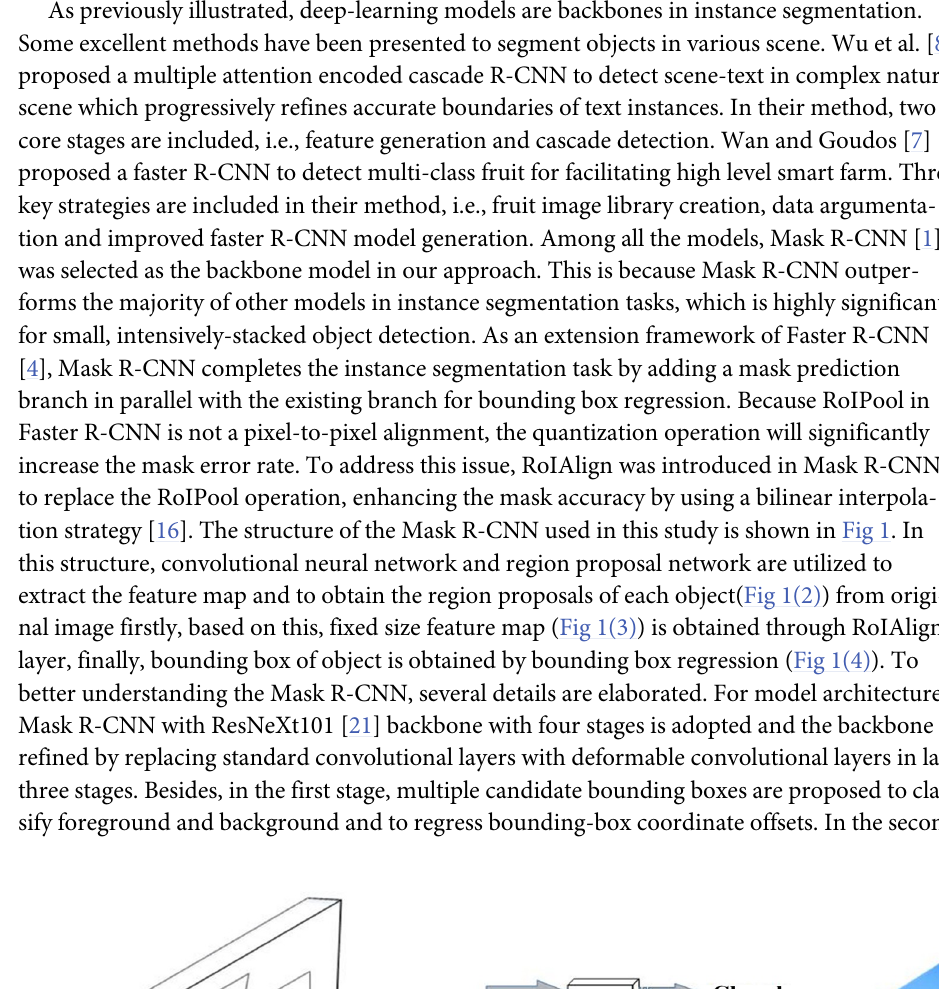
PLOS ONE | https://doi.org/10.1371/journal.pone.0271051 January 26,